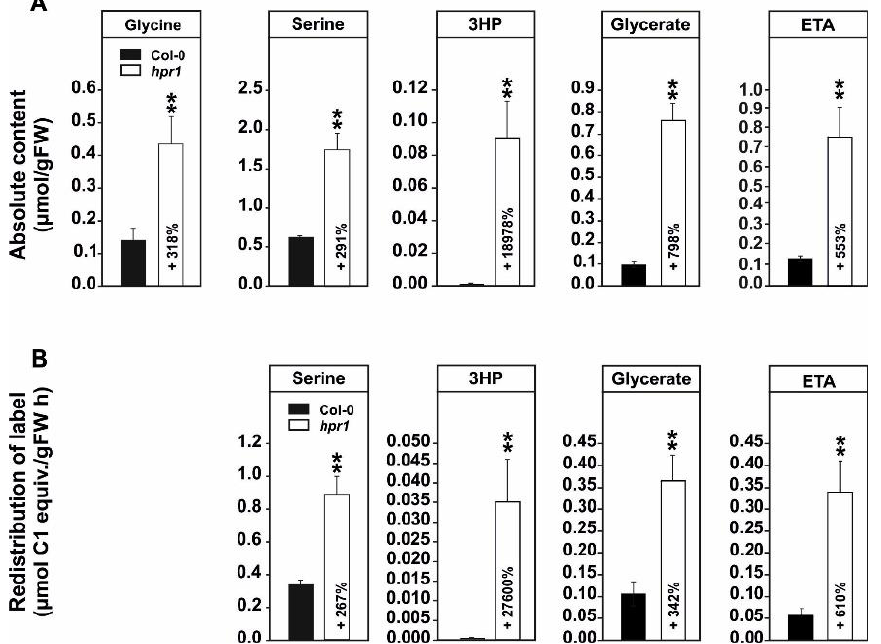
Figure 1. Absolute amounts and carbon isotope redistribution in photorespiratory intermediates and ethanolamine. Shown are ( A ) absolute amounts of selected photorespiratory intermediates and ethanolamine (ETA) and ( B ) redistribution of 13 C in selected photorespiratory intermediates (serine (flux from glycine), 3HP (flux from serine) and glycerate (flux from 3HP)) and ETA (flux from serine) following [U- 13 C]-glucose labeling in the wild type and the hpr1 mutant. Plants were grown under controlled environmental conditions (390 ppm CO 2 , ~120 µmol m −2 light intensity, 20/18 °C day/night temperature, ~70% relative humidity) for 5 weeks (12/12 h day/night cycle). At this time point, leaf-discs were obtained for absolute metabolite quantification and carbon isotope labeling. Shown are means ± SD of five biological replicates (5 leaf-discs per plant) and asterisks show significant changes compared with the wild type according to Student’s t -test (** p < 0.01).